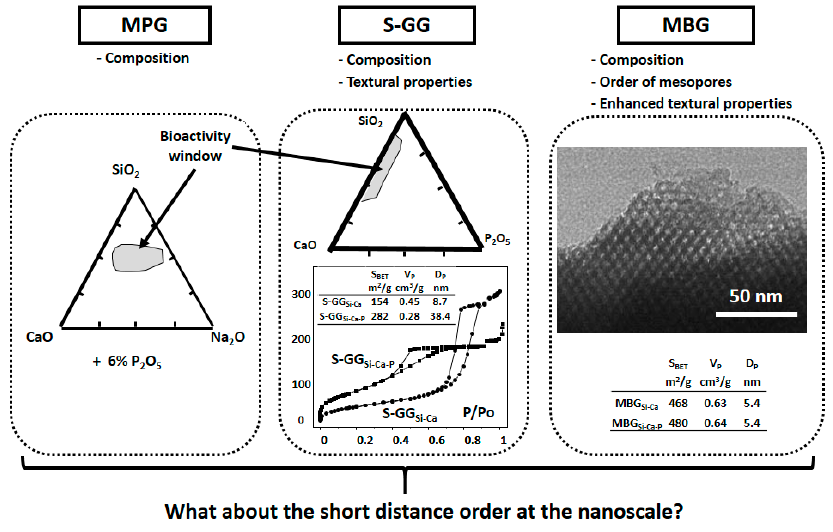
Figure 1. Properties which determine the bioactive response of the three families of BGs: MPGs, S ‐ GGs, and MBGs. In the last decade, the importance of the nanostructure in this response for the three families of BGs has been also